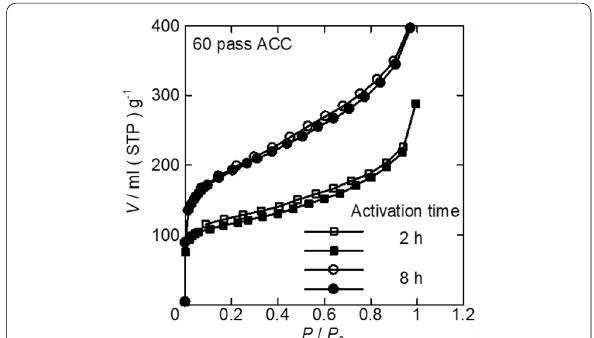
Fig. 6 Adsorption isotherms of 2-h- and 8-h-activated carbons after aqueous counter collision (ACC). Legends are the same as Fig. 2